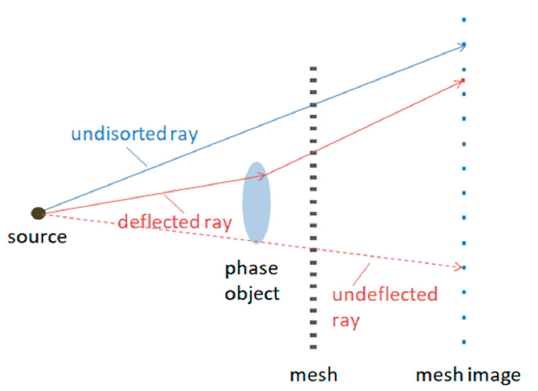
Figure 12. Sketch of the mesh-based phase-imaging setup. The X-ray beam that is deflected by the object creates displacement of the mesh lines on the camera. After the Fourier transformation of the absorption image, the zeroth-order harmonic contains the absorption-image information, and the first-order harmonic contains infor- mation on the differential phase-contrast image [99]. Both images can be obtained by win- dowing these harmonics in a Fourier space and taking their inverse Fourier transform. This method obtains absorption, differential phase contrast, and scattering amplitude im- ages from a single raw image. In 2012, Morgan et al. developed X-ray phase imaging with sandpaper by replacing the mesh with sandpaper. The results showed some advantages for live imaging in com- pared to single-exposure X-ray imaging [100]. Wired-mesh-based imaging works with low brightness and noncoherent sources bring a large FOV, and delivers high contrast but low dosage with a rapid single shot. This method is promising not only in biological and life science but also in security screen- ing. 2.7. Diffraction-Enhanced Imaging (DEI) Diffraction-enhanced imaging (DEI) derived from the contrast from absorption, re- fraction, and extinction was developed by Chapman et al. in 1997 [30]. As shown in Figure 13, this method is based on two crystals, which is also referred to as analyzer-based imag- ing. Figure 13. Sketch of diffraction-enhanced imaging (DEI) setup. Two crystals work as monochromator and analyzer.